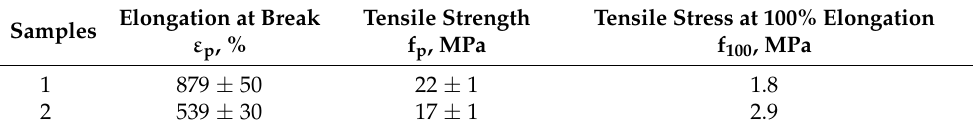
Figure 5. Stress-strain curve of the tensile tests.